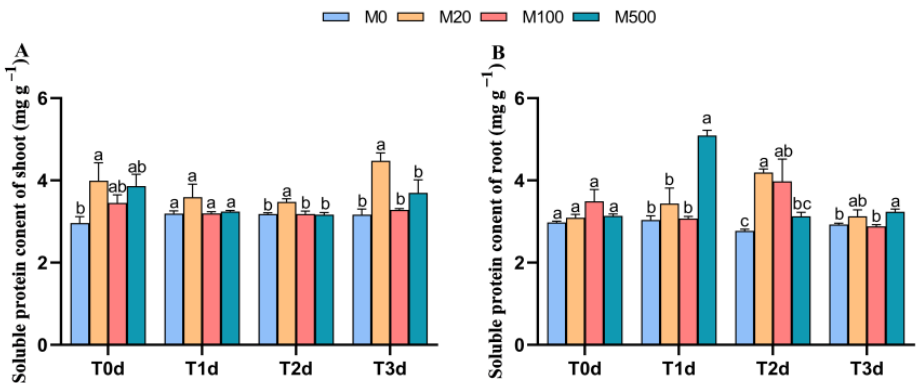
Figure 5. Effects of melatonin and flooding stress on soluble protein content of shoots ( A ) and soluble protein content of roots ( B ). Different letters represent statistically significant differences ( p < 0.05).